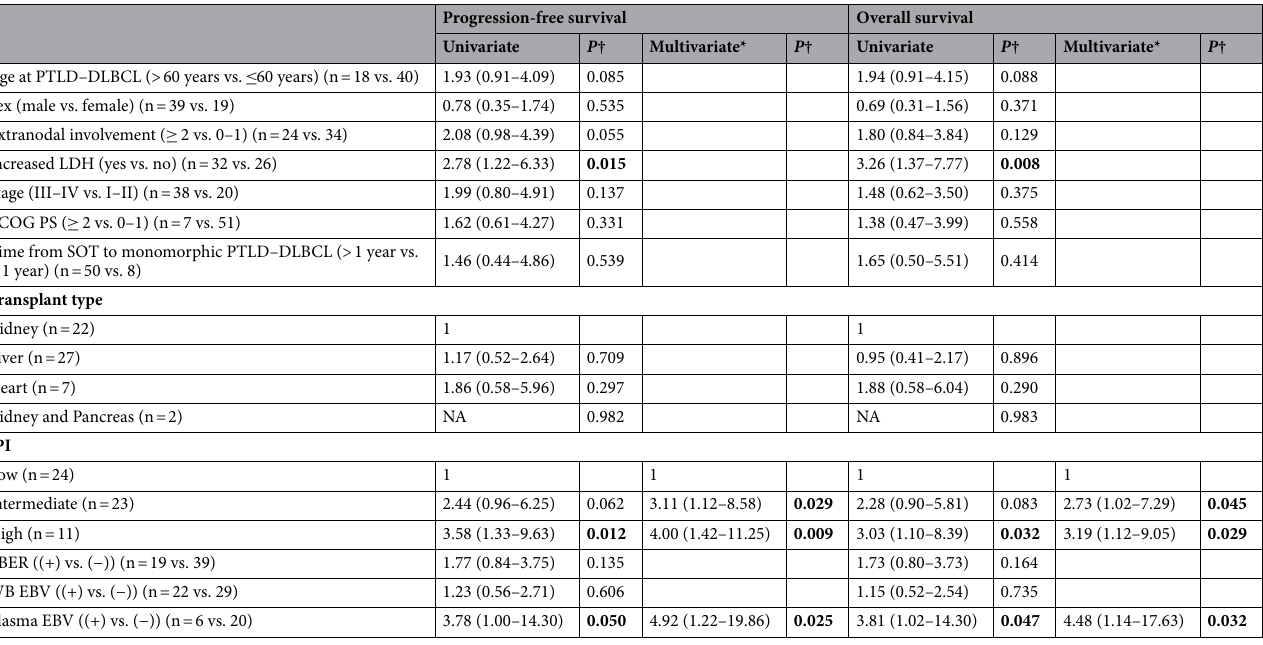
Table 3. Univariate and multivariate analysis for progression-free survival and overall survival. Significant P values are given in bold. † P values were estimated using the Cox proportional regression model. *In the multivariate analysis, variables exhibiting a potential association with survival ( P < 0.1) in the univariate analysis, along with EBER, WB EBV, and plasma EBV were included. IPI was included in multivariate analysis as a categorical variable; low (0–1 risk), intermediate (2–3 risks), and high (4–5 risks). PTLD post- transplantation proliferative disorder, DLBCL diffuse large B-cell lymphoma, SOT solid organ transplant, NA not applicable, EBER Epstein-Barr virus-encoded small ribonucleic acids, WB whole blood, EBV Epstein-Barr virus, IPI international prognostic